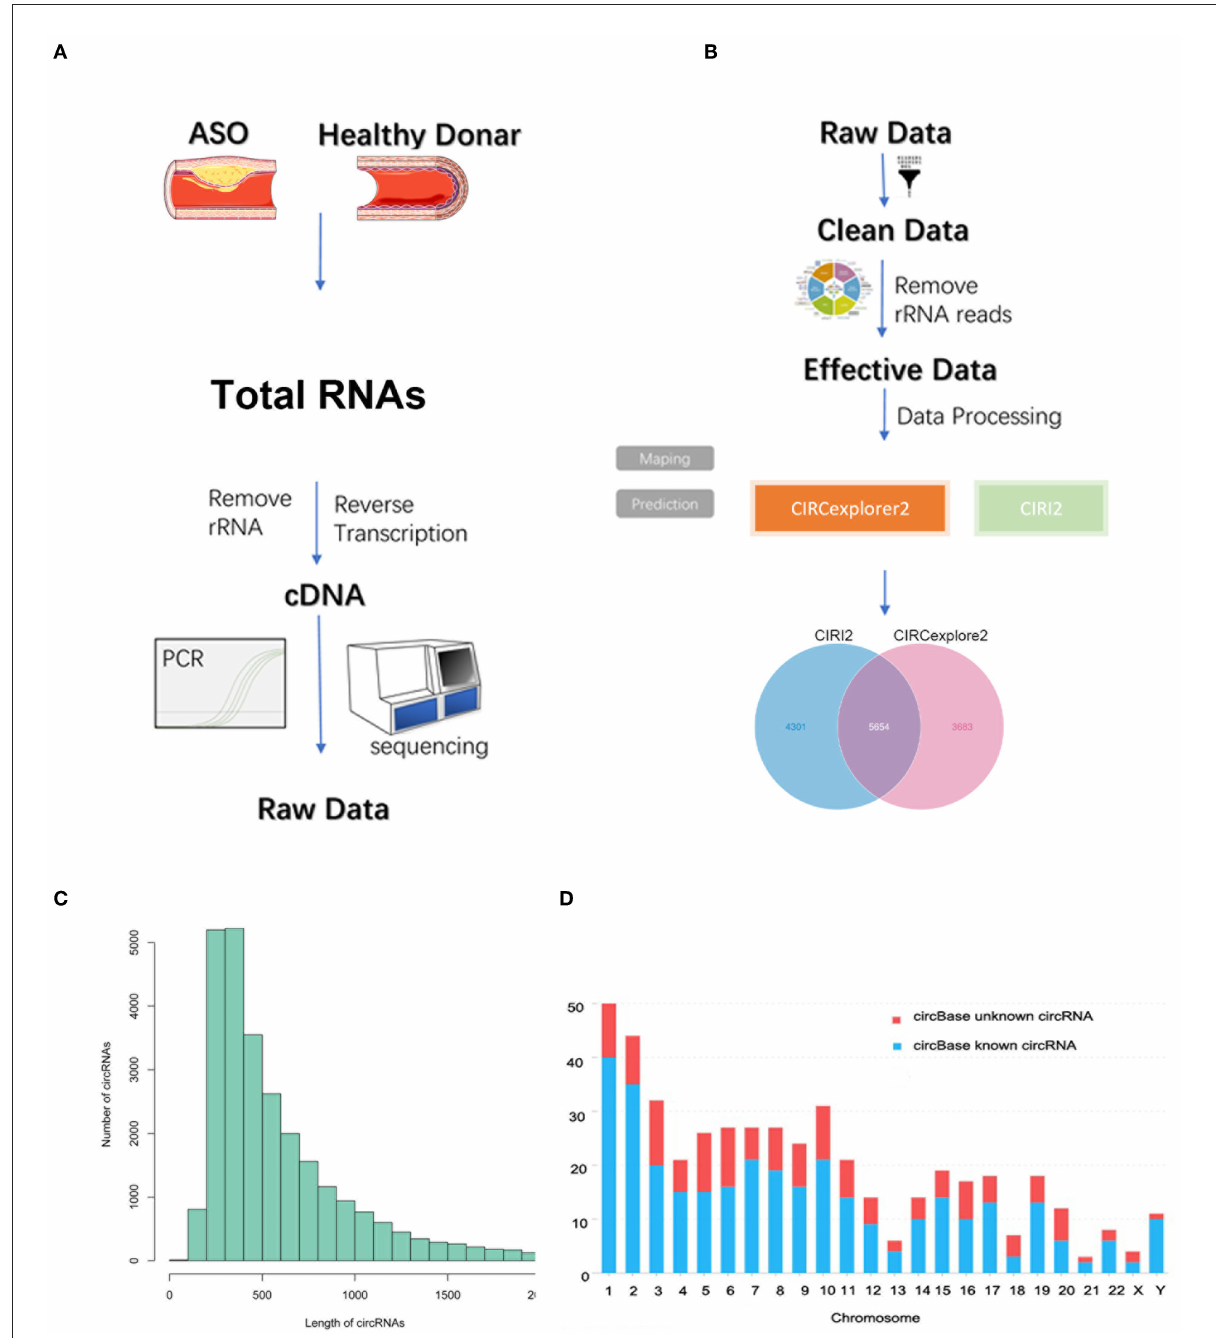
FIGURE1 Circular RNA (circRNA) sequencing of the artery tissue workflow. (A,B) The workflow of circRNA sequencing using arterial tissues from patients with arteriosclerosis obliterans (ASO) and healthy donors; (C) Column distribution map for the lengths of circRNAs; and (D) circRNA distribution in each